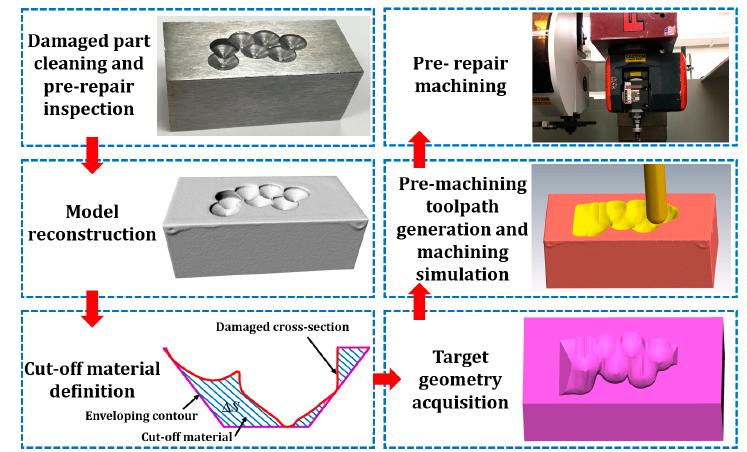
Figure 3. Pre-repair machining procedure for surface impact defects.